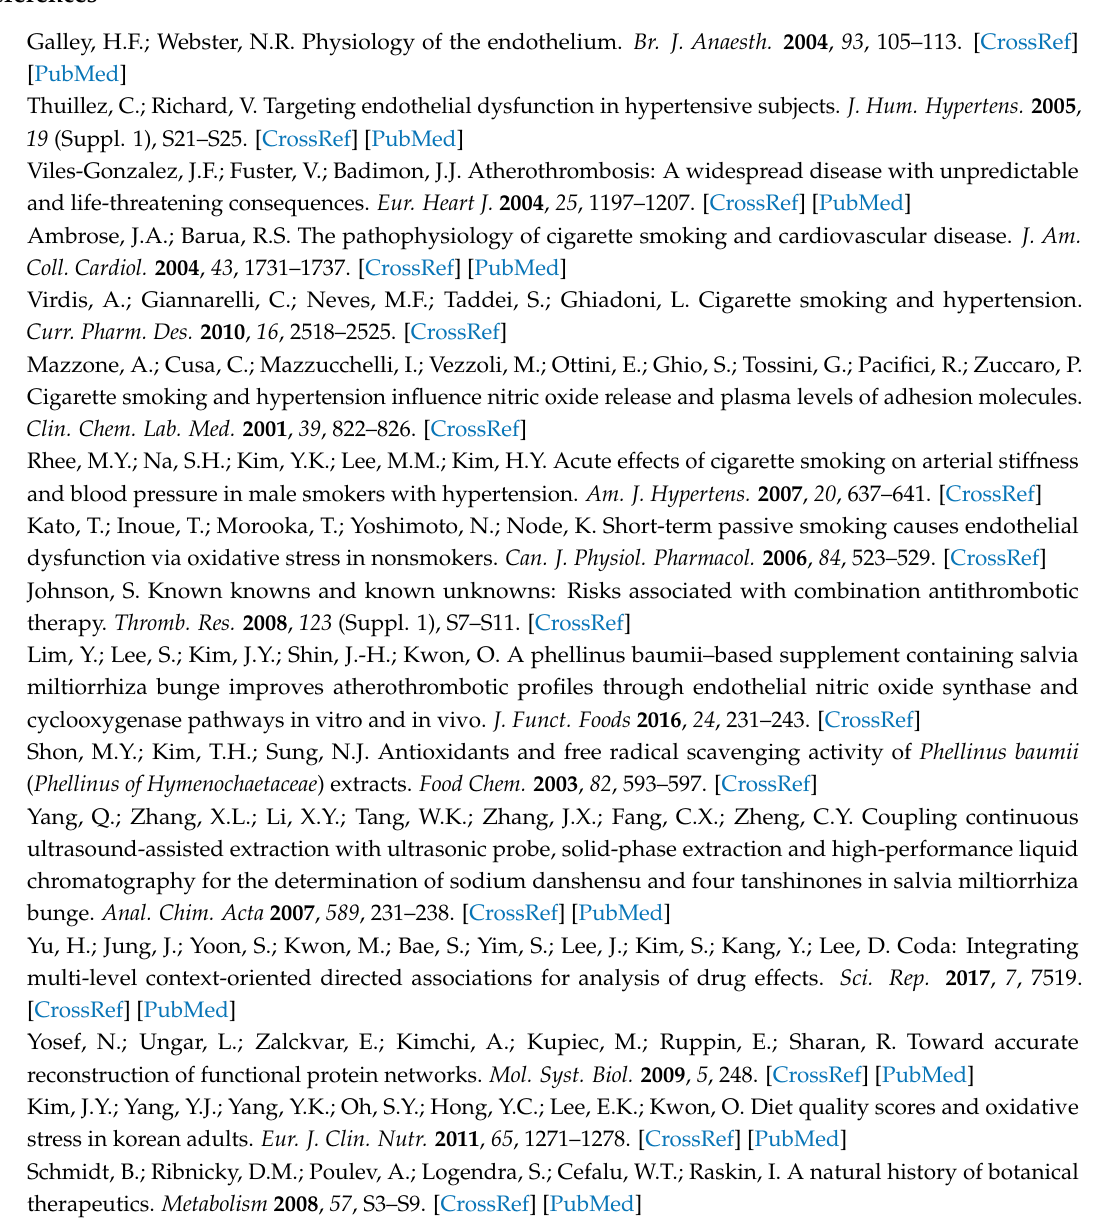
Table S1: List of the 21 metabolites with the VIP > 1, Table S2: Significantly altered metabolites and their related metabolic pathways, Table S3: Overall network consisting of 218 nodes and 497 edges, and Table S4: Subnetwork comprising 6 bioactives and 15